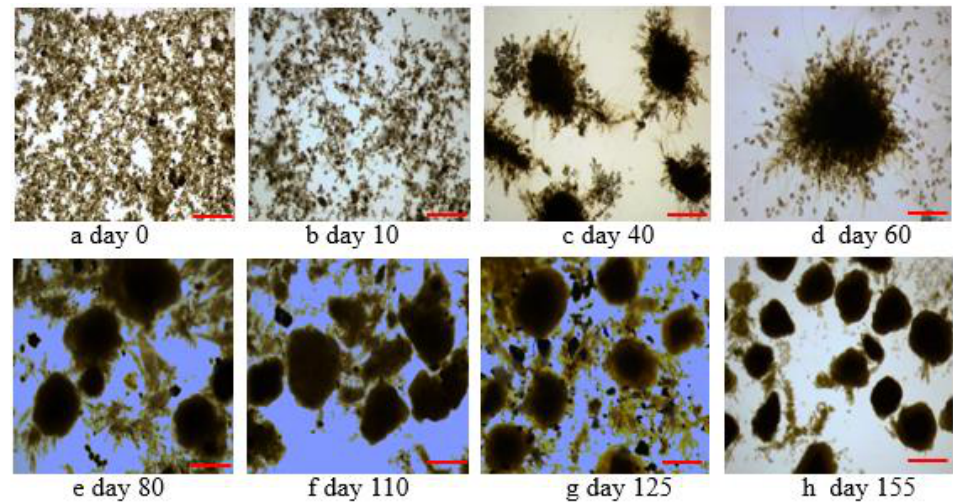
Figure 1. Photographs of sludge in different phases, scale bar: 1 cm.